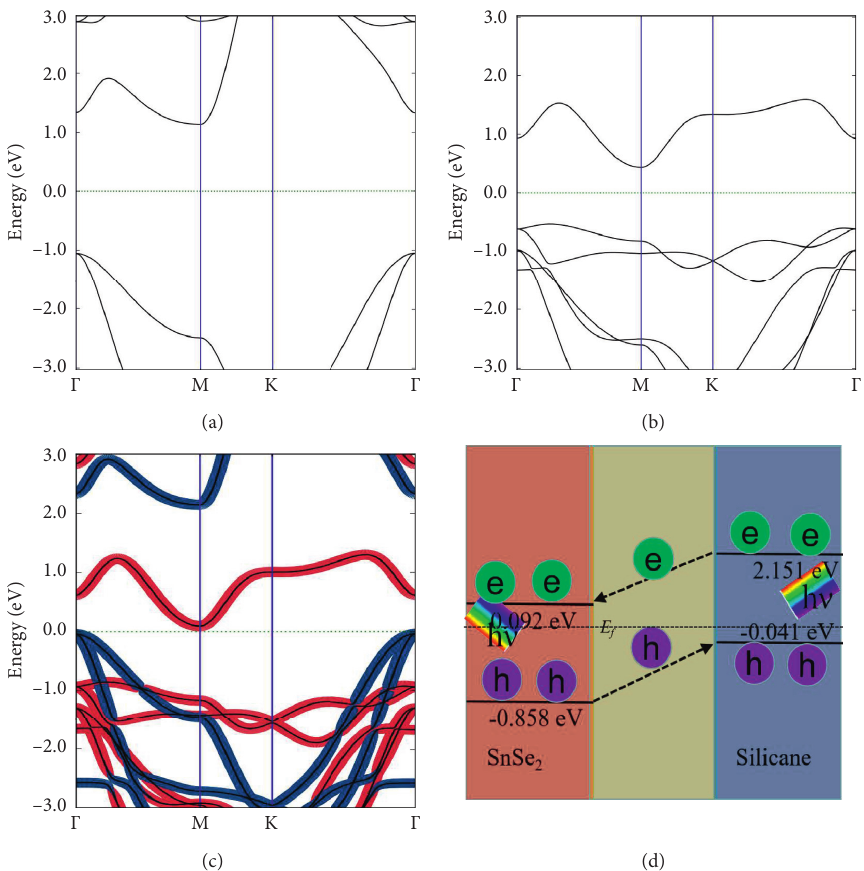
Figure 1: Graphs showing the band structures (in terms of units of energy) of (a) the silicane and the (b) SnSe band structures of the silicane/SnSe 2 vdW heterostructure are also given. Here, the dull-red lines represent SnSe 2 , while the dark blue lines denote silicane. (d) A depiction of the band offset of the silicane/SnSe 2 vdW heterostructure is also